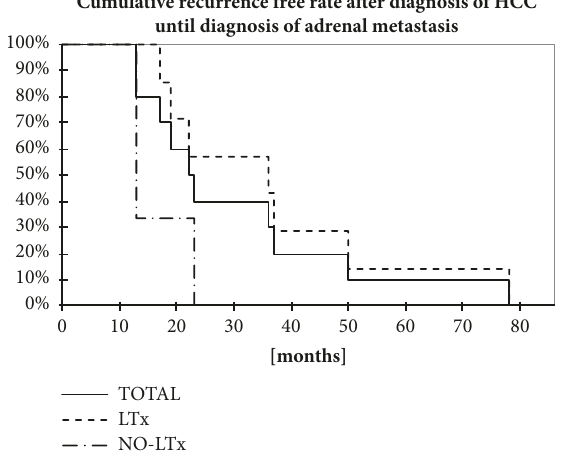
Figure 1: Display shows Kaplan-Meyer-Analysis of recurrence-free rate after the primary diagnosis of HCC until the occurring diag- nosis of an adrenal metastasis depending on the primary treatment of the HCC either liver transplantation or resection/afterloading.